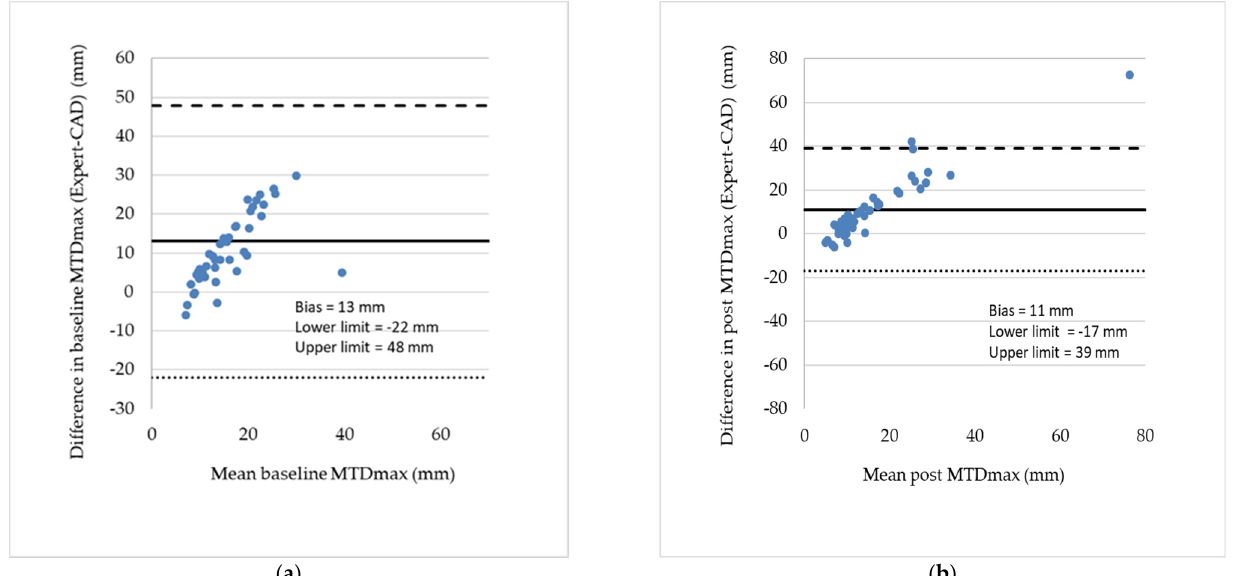
Figure 4. ( a ) Bland–Altman plot showing the differences between expert and CAD baseline meas- urements of MTDmax for all patients. ( b ) Similar plot for the post treatment measurements of MTDmax. The bias (mean value of the differences) and the lower and upper limits of agreement are shown in the inserts. In both pre and post treatment measurements, the differences tend to increase as the mean MTV increases. Variability (scatter) does not change significantly, while there is a linear trend in both plots, namely, differences increase as the mean MTDmax increases.